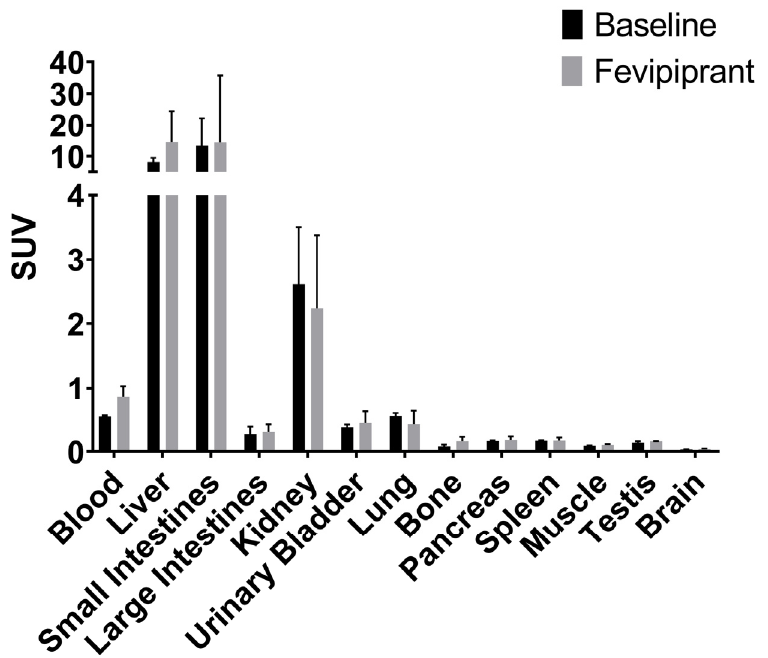
Figure 7. Endpoint biodistribution 90 min post-injection of [ 18 F]MK-7246 in n = 3 baseline rats and n = 3 rats injected with GPR44 antagonist Fevipiprant (1 μ mol).